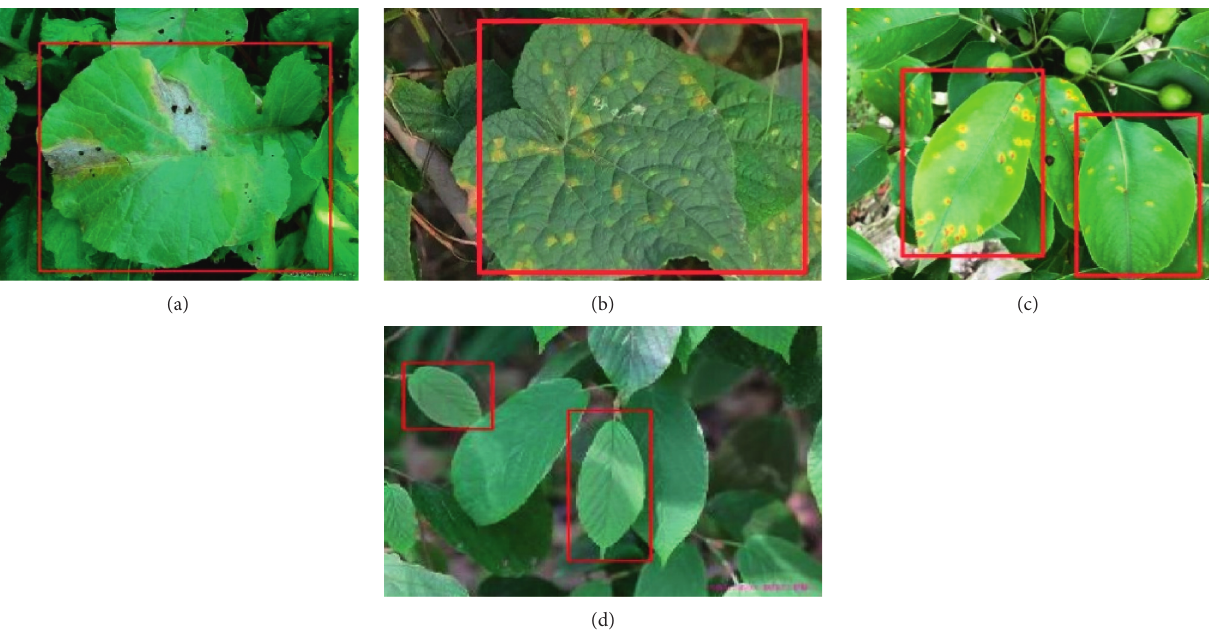
Figure 8: Leaf retrieval results in complex environment: (a) black rot disease; (b) bacteria plaque disease; (c) rust disease; (d) healthy leaf.